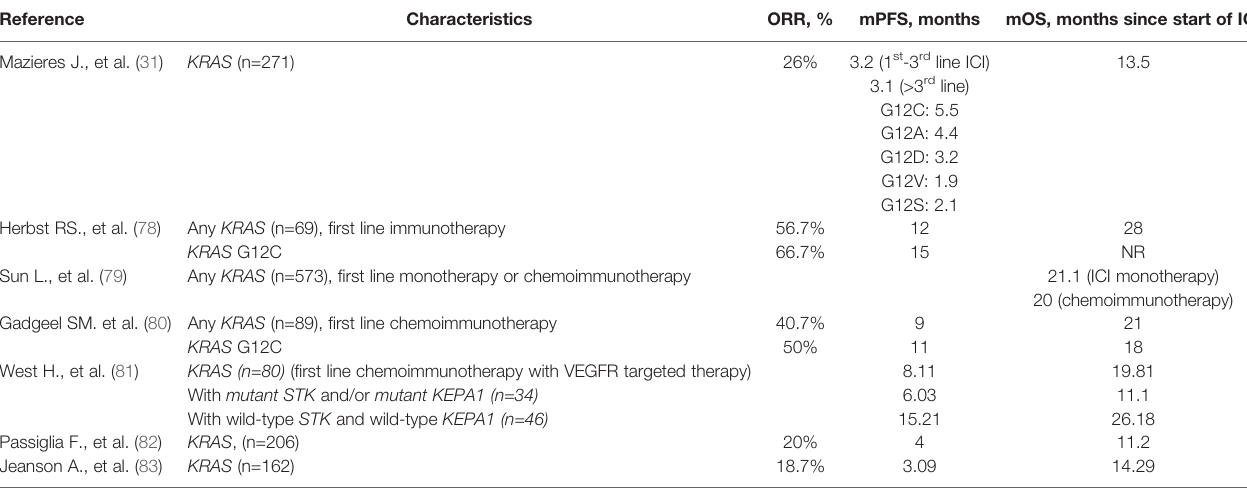
TABLE 7 | Ef fi cacy of ICIs in NSCLS with KRAS mutations. Reference